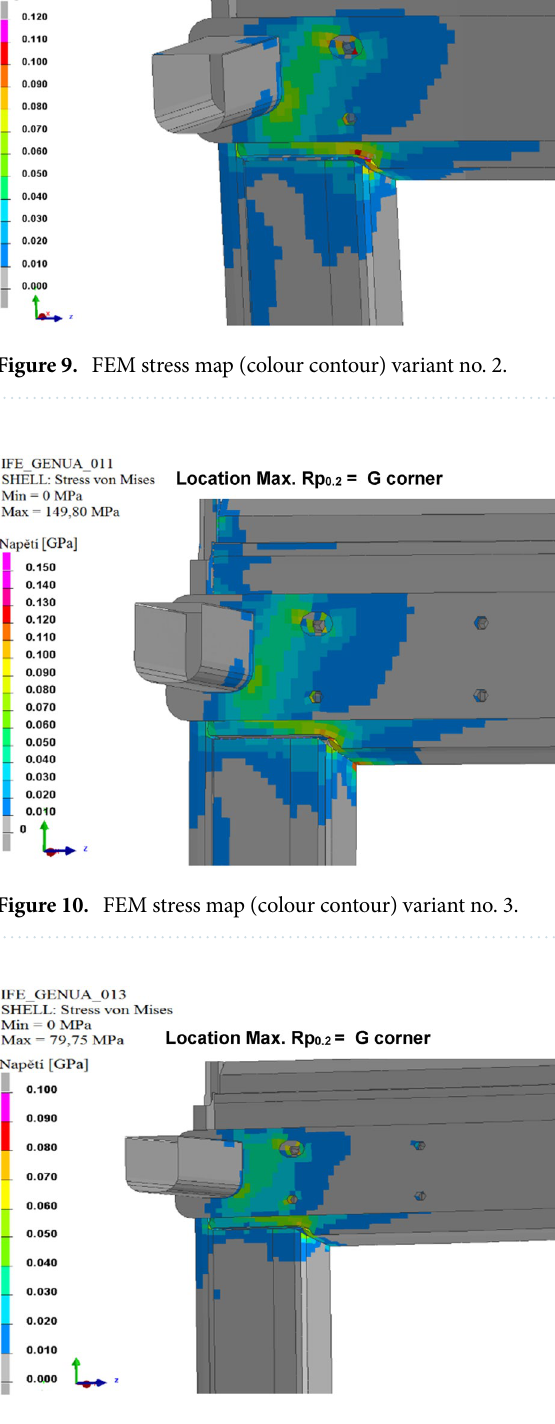
Figure 11. FEM stress map (colour contour) variant no.